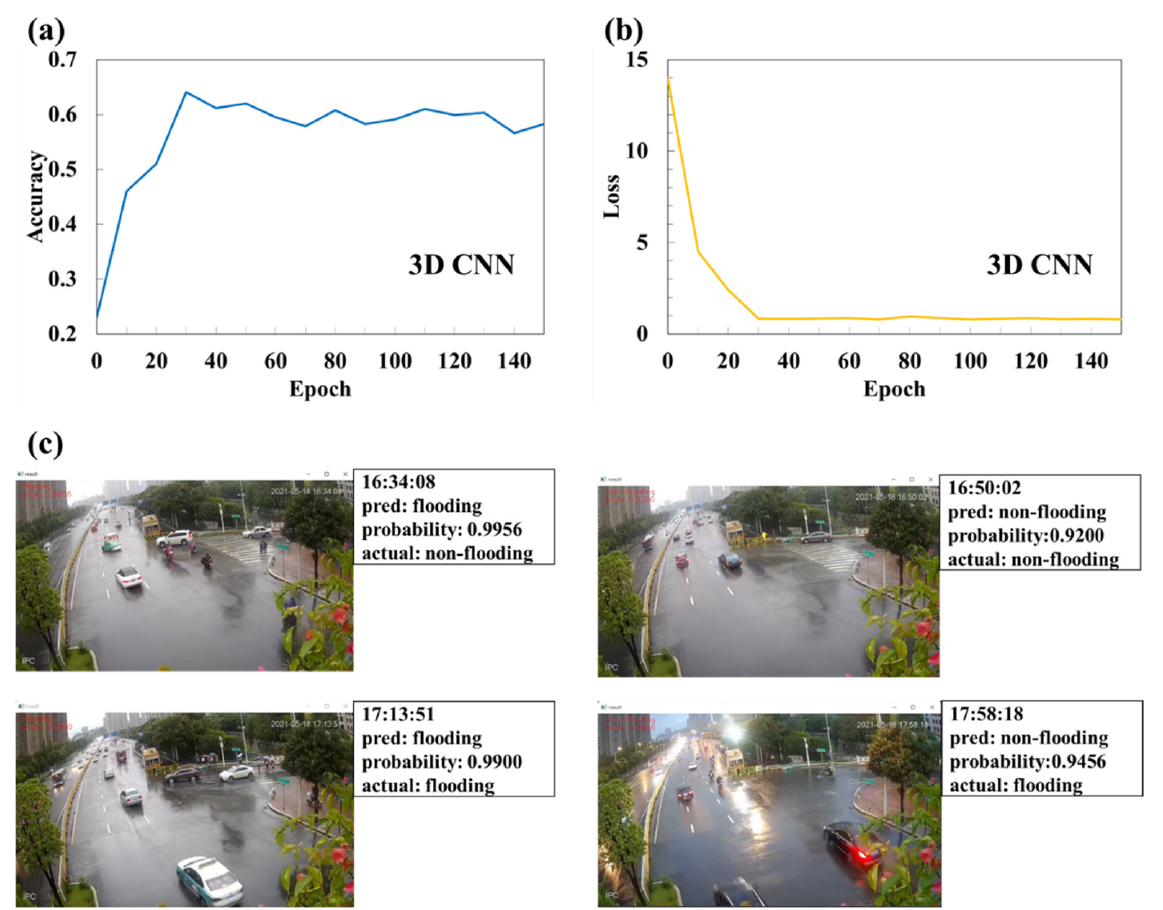
Figure 19. Video classi fi cation using the 3D CNN.